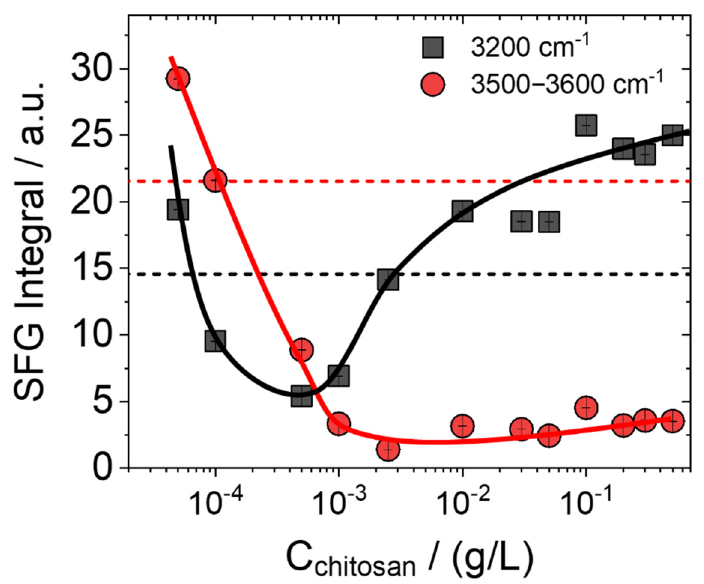
Figure 2. Integrated SFG intensities of O-H stretching bands (3055–3355 cm − 1 ) related to the hydro- gen-bonded interfacial water molecules (black squares), which is also dependent on the net charging state of the interface, as discussed in the main text. Integrated SFG intensities (3393–3695 cm − 1 ) from O-H groups at the oligosaccharide glycone of the saponin (red circles) as well as from water mole- cules close to the hydrophobic parts of the chitosan/saponin mixtures at the interface are also shown as a function of the chitosan concentration. Red and black dashed lines show the SFG intensities of both contributions to the SFG spectra (bands at 3200 and ~3550 cm − 1 ). Solid lines guide the